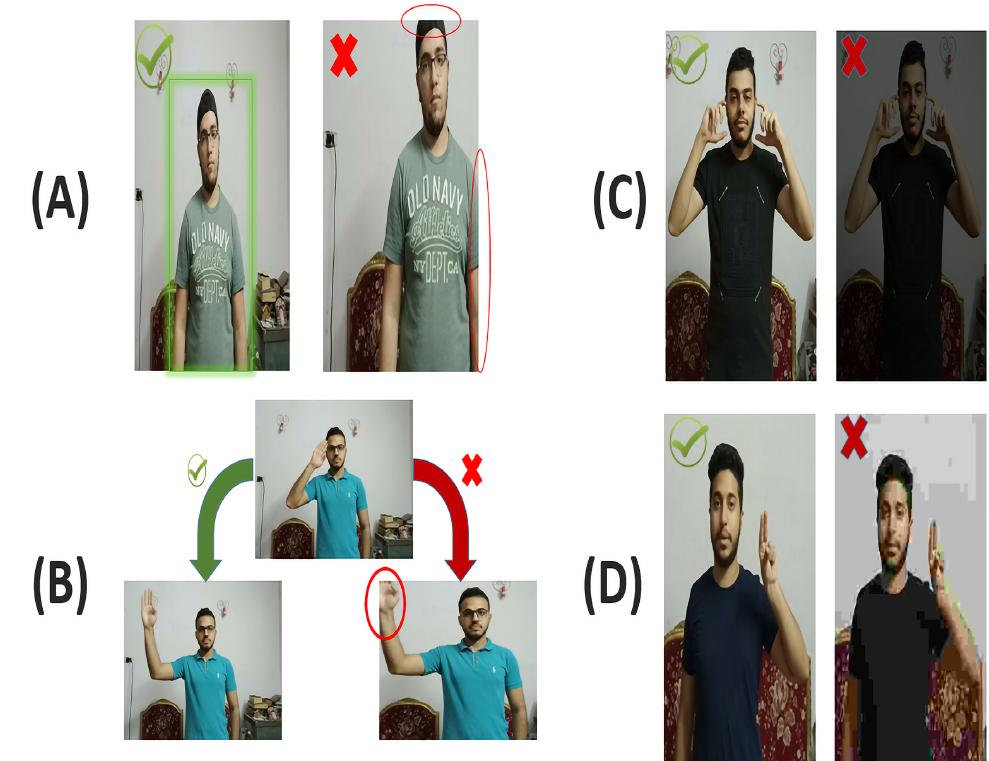
Figure 8. Instructions for recording a clean and clear dataset regarding ( A ) Signer body, ( B ) Signer movement, ( C ) Lighting and ( D ) Camera